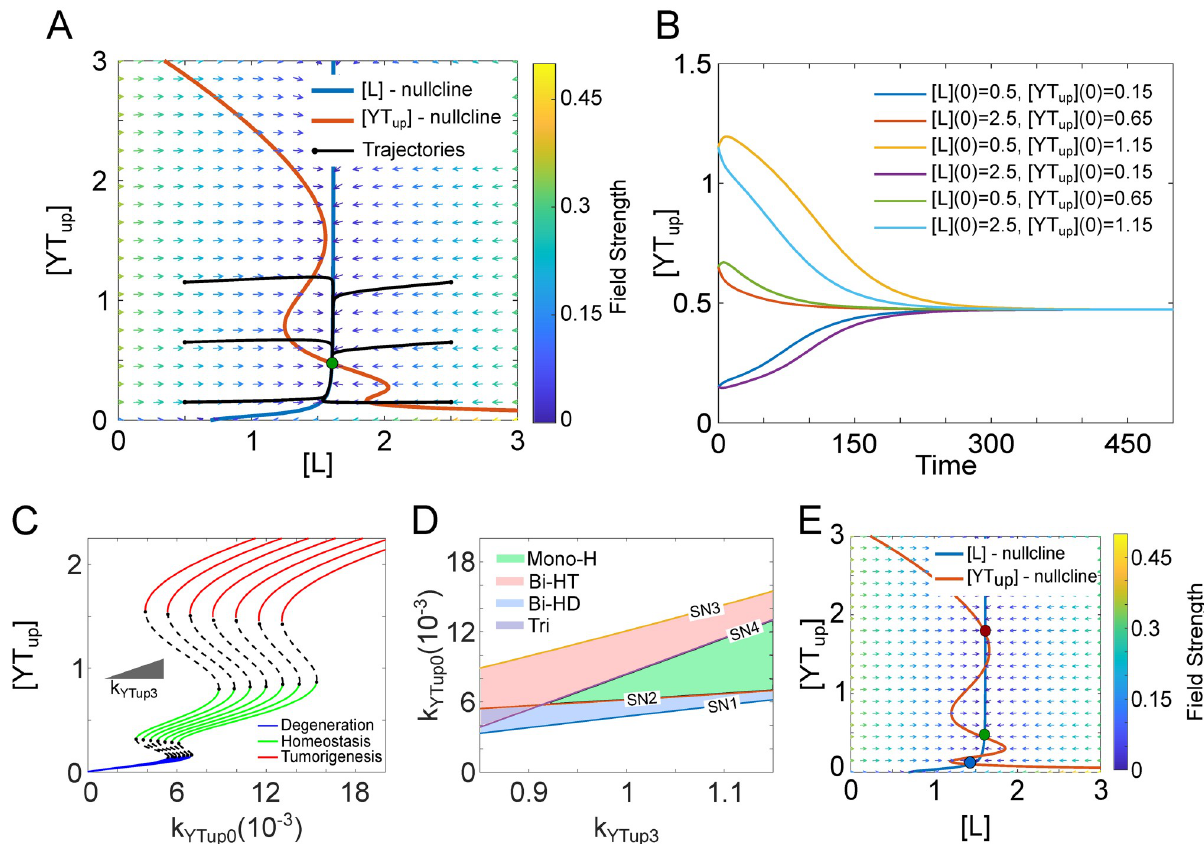
Fig 3. Tissue homeostasis is regulated by YAP/TAZ/LATS negative feedback loop. (A) Nullcline analysis of the regulatory system shows one stable steady state (tissue homeostasis, green circle) at the intersections of the nullclines under basal parameter set. The [ L ]-nullcline is drawn in blue and the [ YT ]-nullcline is drawn in red. The vector field of the system is represented by small arrows, where the color is proportional to the field strength. up Example trajectories starting from different initial states were shown to represent the dynamics of the system towards the tissue homeostatic state. (B) The time course of the [ YT up ] level with the system starting from a range of initial conditions. (C) The parameter k YTup 3 , characterizing the strength of the YAP/TAZ-LATS1/2 negative feedback loop, was varied from 85% to 115% (left to right), with 5% increments, of its original value to plot the 1-parameter bifurcation diagrams and show its effect on the homeostatic state. (D) Two-parameter bifurcation analysis shows how the thresholds SN1, . The monostable homeostatic state region is labeled as Mono-H (green), and the tristable region is labeled as Tri SN2, SN3, and SN4 vary with k YTup 3 (purple), respectively. The bistable region in which the homeostatic and tumorigenic states existed within is labeled as Bi-HT (red), while the bistable region in which the homeostatic and degenerative states existed within is labeled as Bi-HD (blue). (E) Nullcline analysis of the regulatory system shows the three stable steady states and two unstable steady states when k is within the tristable region (between SN2 and SN4) and k is 85% of its YTup 0 YTup 3 original value.